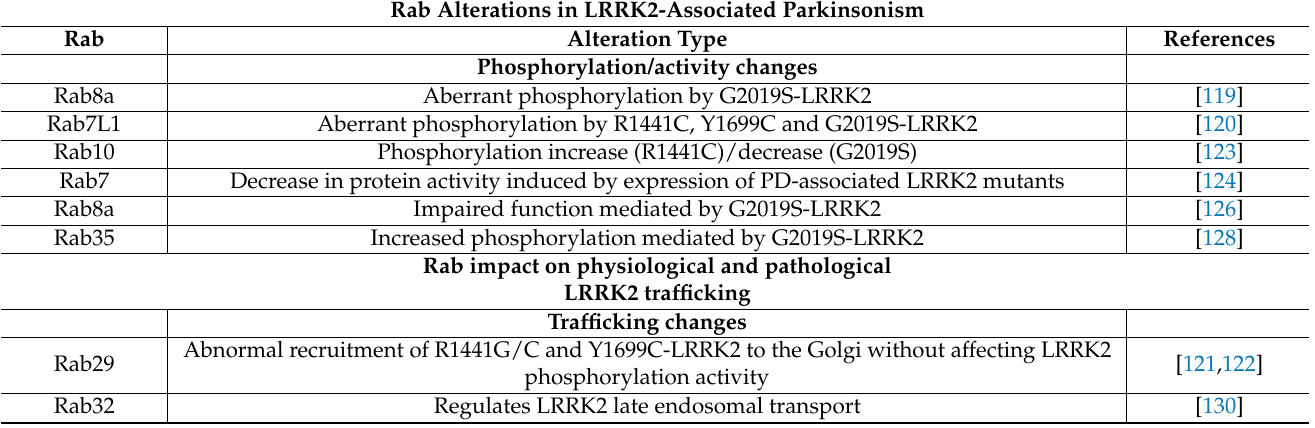
Table 2. Alterations in Rabs in LRRK2-associated parkinsonism and the effect of Rabs on LRRK2